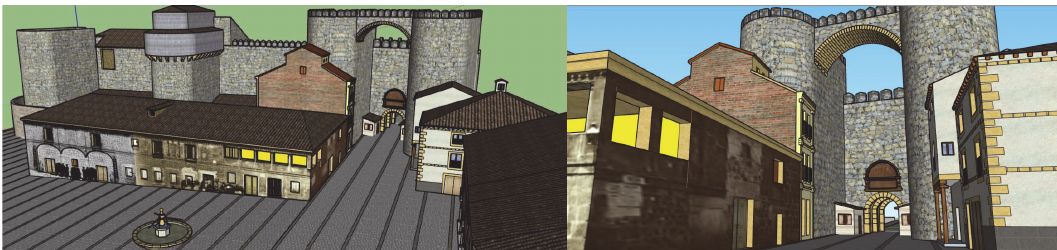
Figure 5. Extramural buildings: Old photograph texture integration (Laurent, c. 1865, Ruiz Vernacci Archive, VN-17214) with 4D modelling for the extramural section of the Alcázar Gate . Source: Cultural Heritage Institute of Spain (IPCE).